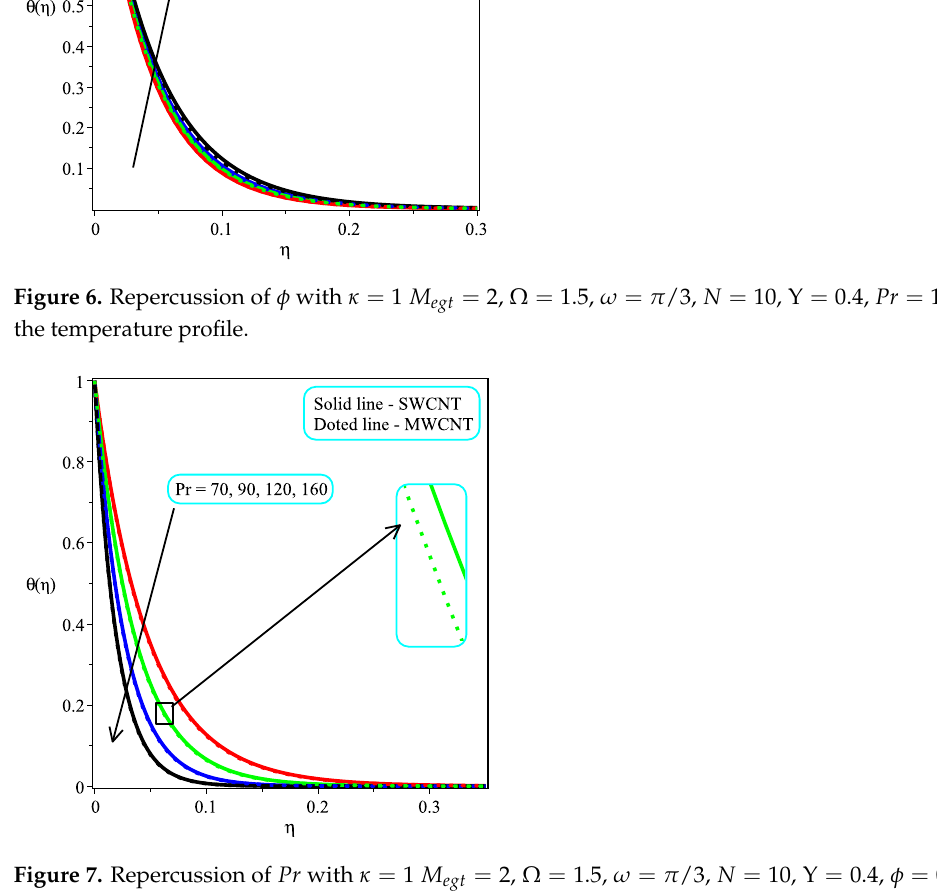
Figure 7. Repercussion of Pr with κ = 1 M egt = 2, Ω = 1.5, ω = π /3, N = 10, Υ = 0.4, φ = 0.1 on the temperature profile.